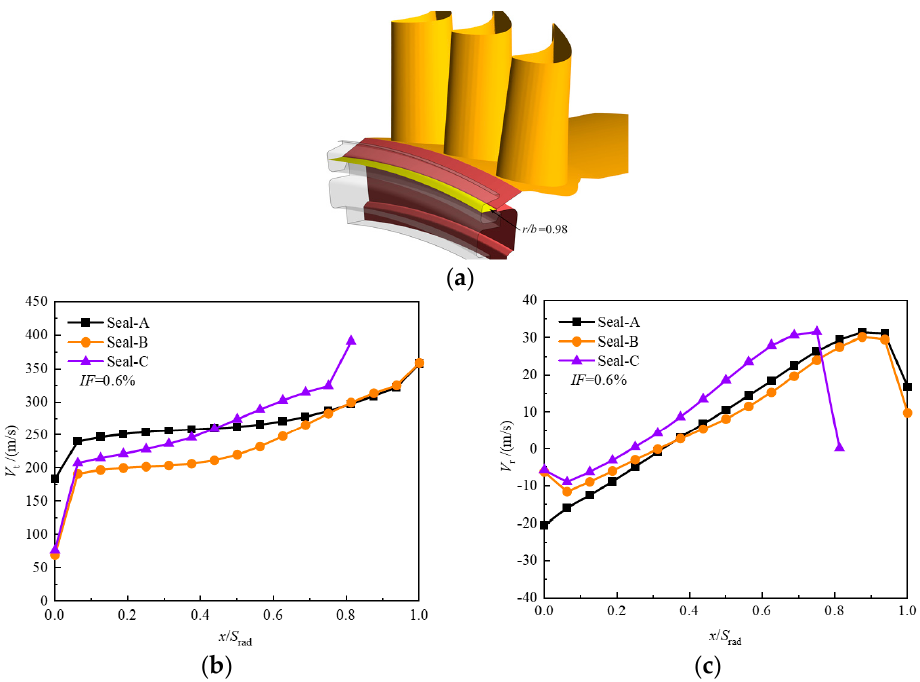
Figure 21. Time-averaged tangential and radial velocity variations along the axial direction at the middle section of the sealing cavity for IF = 0.6%: ( a ) position of the section in the middle of the sealing cavity; ( b ) time-averaged tangential velocity; and ( c ) time-averaged radial velocity.